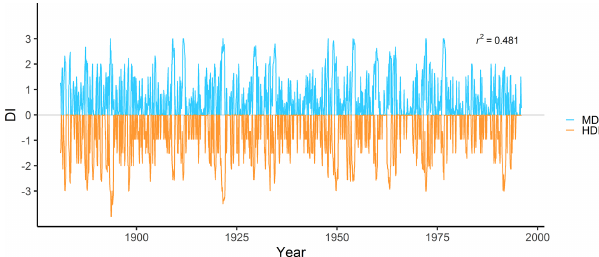
Figure 7. Comparison of the historical drought index (HDI) and the modern drought index (MDI) for Germany